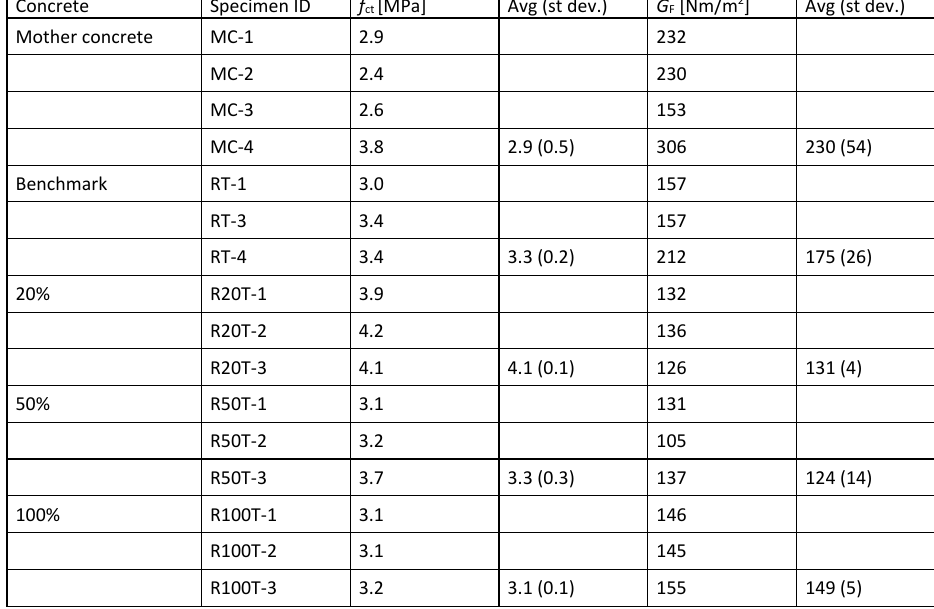
Table 3 . Monotonic tensile test result summary.